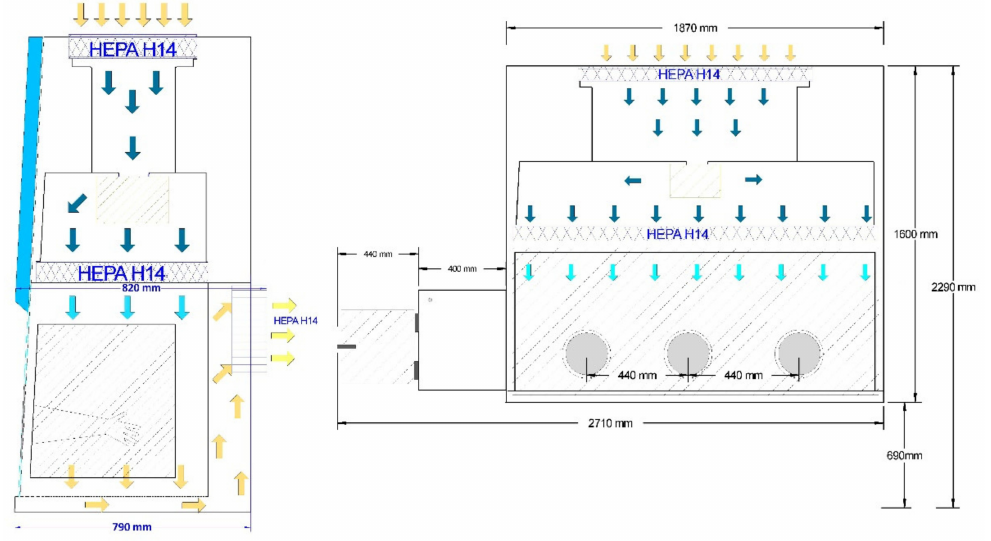
Figure 3. Front and side view of the isolator filtration system. HEPA: High-Efficiency Particle